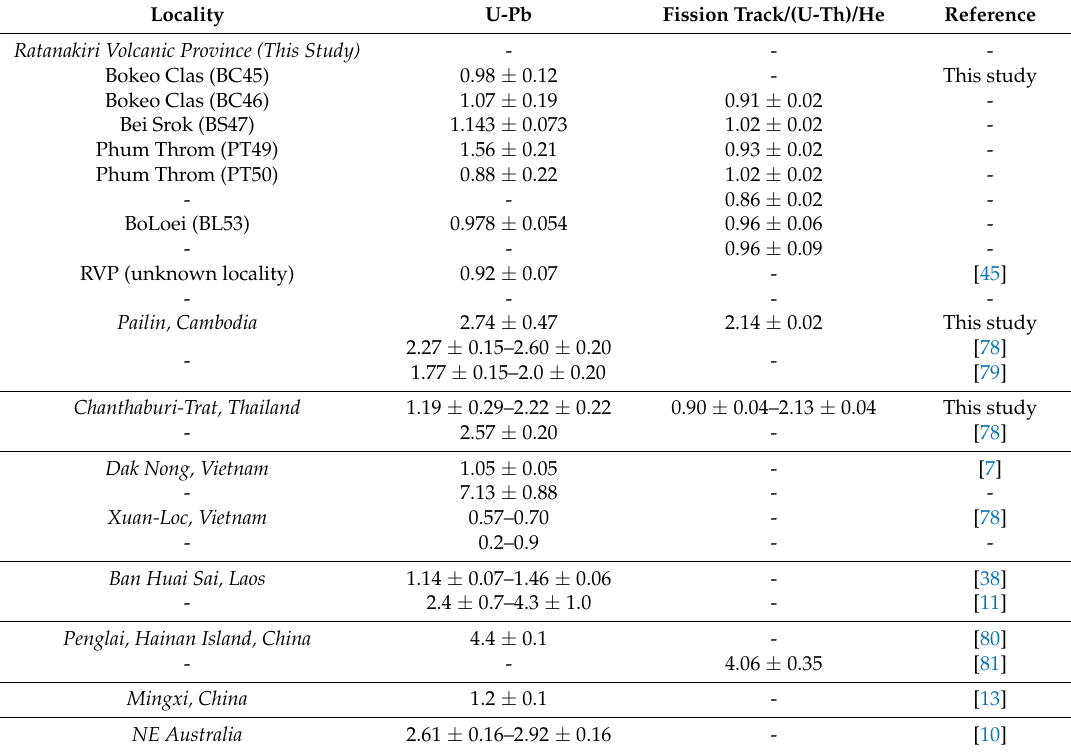
Table 4. U-Pb, fission track and (U-Th)/He age dates for ZIP xenocrysts. Locality